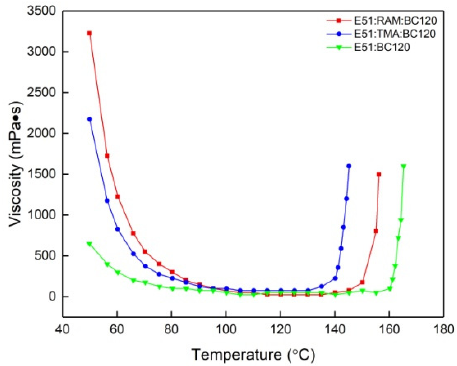
Figure 7. Viscosity-temperature curves for the 3 model systems in comparison.